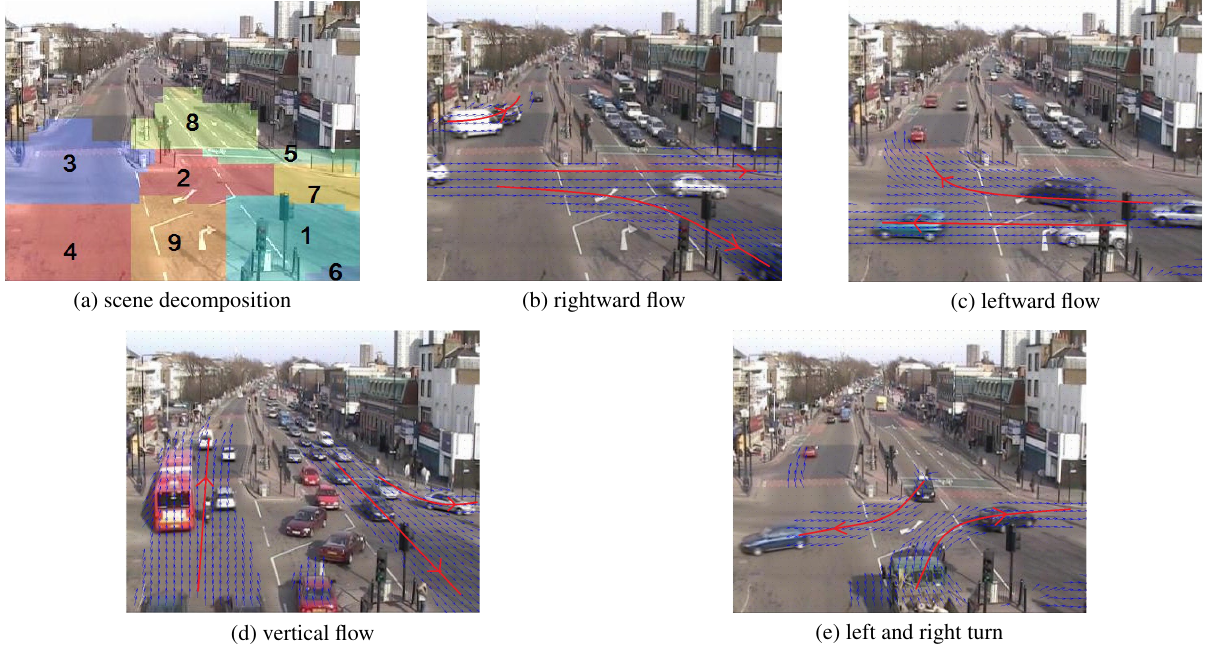
Figure 2: (b)-(e) four main different traffic flows, they are sorted according to the traffic light cycle, (a) result of the semantic scene